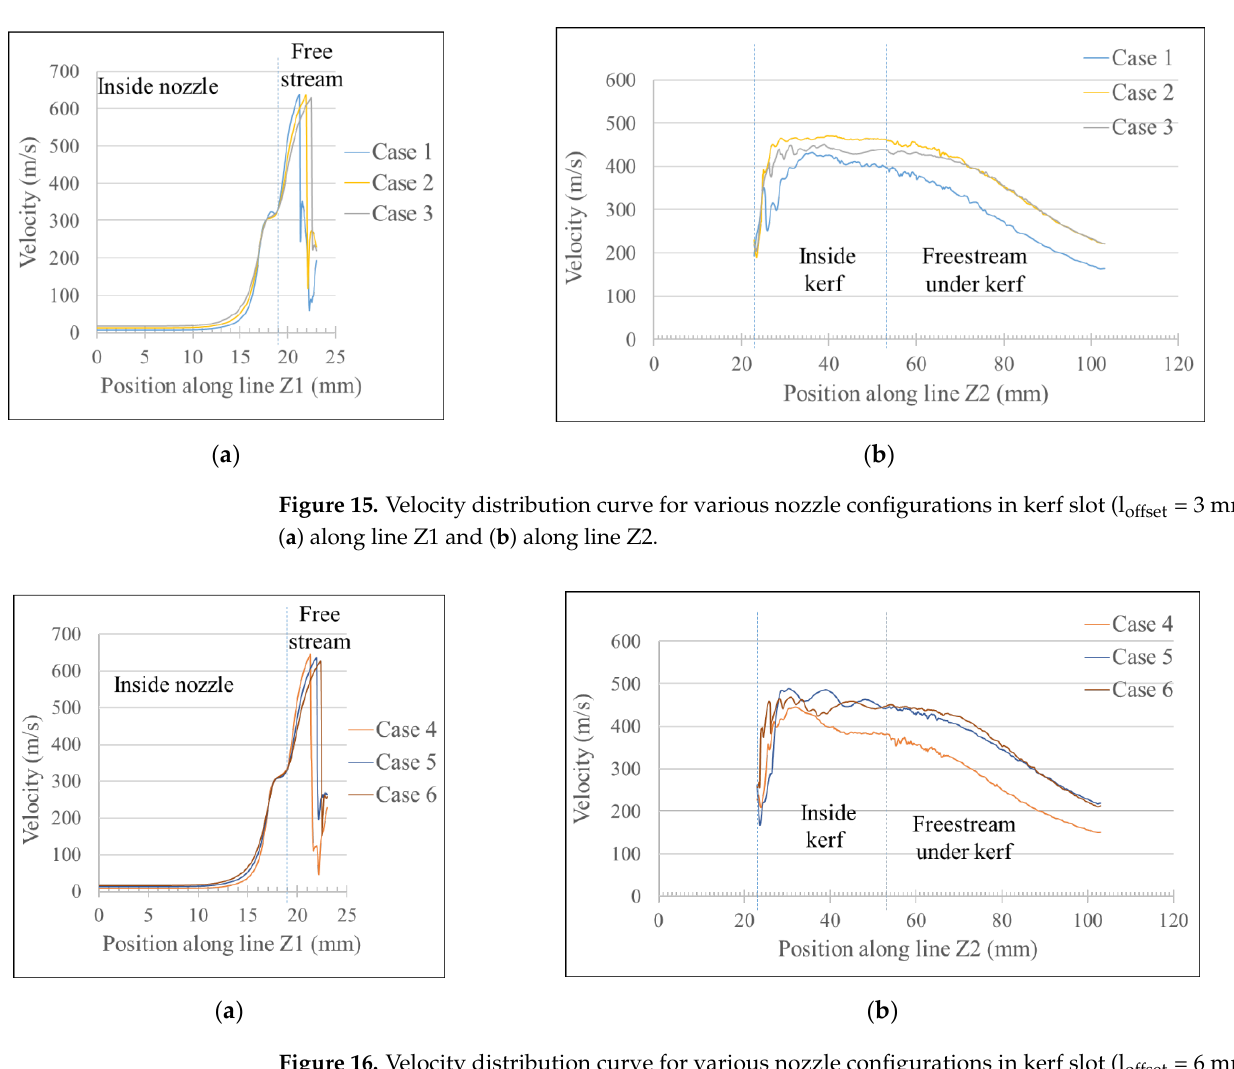
Figure 16. Velocity distribution curve for various nozzle configurations in kerf slot (l offset = 6 mm): ( a ) along line Z1 and ( b ) along line Z2.